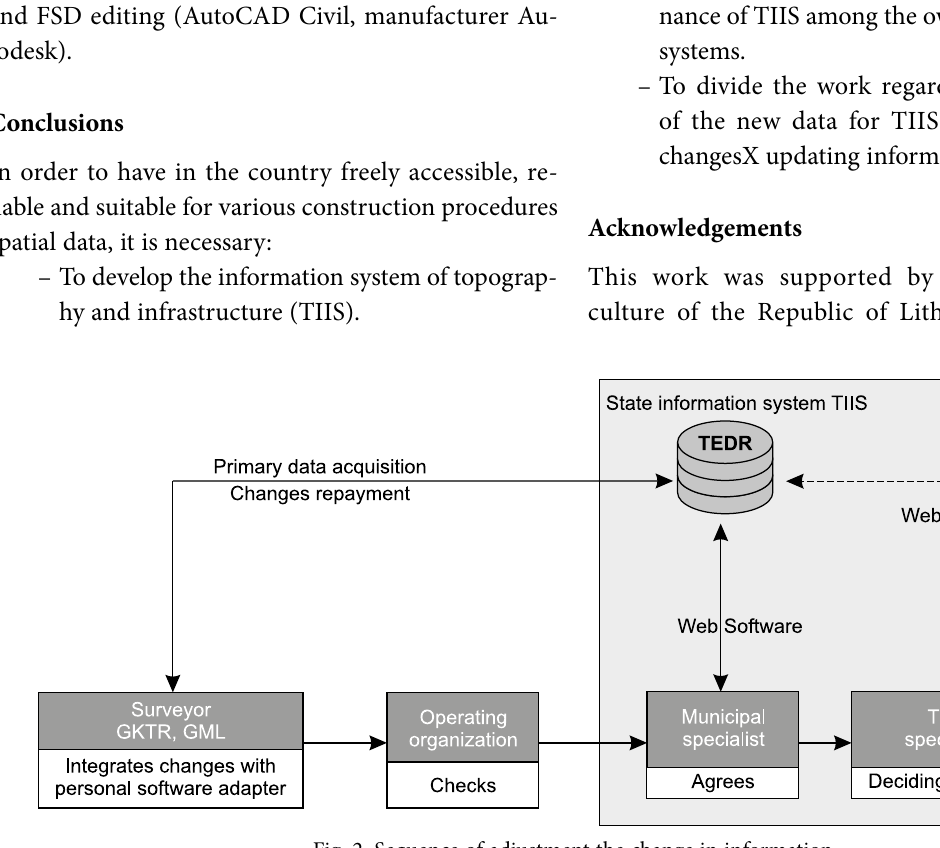
Fig. 2. Sequence of adjustment the change in information